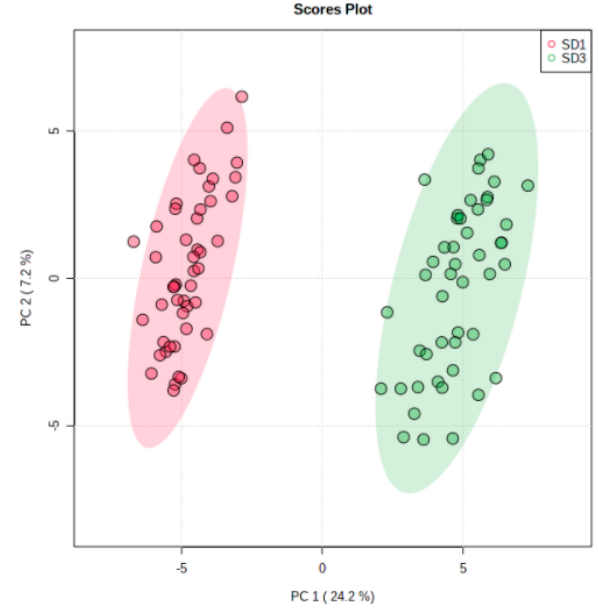
Figure 1. Principal component analysis (PCA) results for comparison of paired plasma samples from 47 pregnant (red) and postpartum (green) women. This aligns with the legend in the upper right where SD1 = study day 1 (pregnant) and SD3 = study day 3 (postpartum). The 980 identified metabolites were used to find the dimensions of greatest variation between the two groups with subjects serving as their own controls. Percent variance values explained by the principal components 1 and 2 are 24.2% and 7.2% respectively.